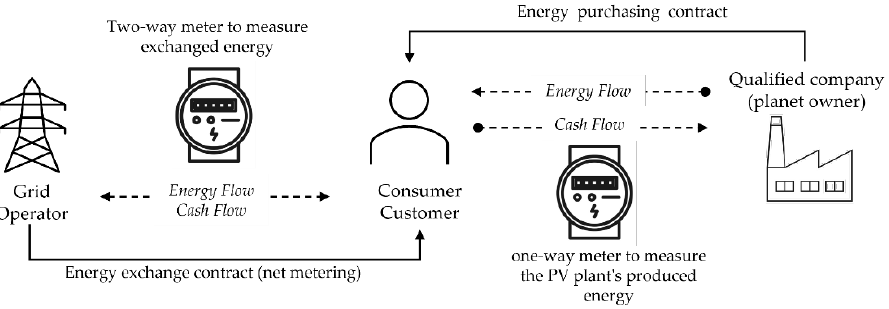
Figure 5. Contractual mechanism of energy purchasing agreement within the net metering scheme.